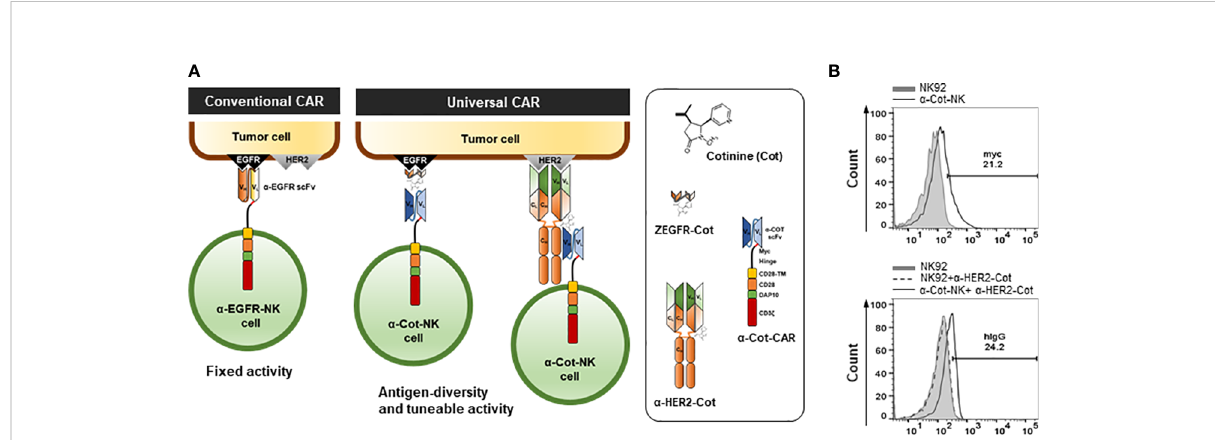
FIGURE 1 Engineering and establishment of a -Cot-NK92 cells as a universal CAR system (A) The conventional and universal CAR-NK system. (B) Levels of surface expression of CAR in NK92 or a -Cot-NK92 cells with/without a -HER2-Cot. The a -Cot-NK92 cells were cultured with puromycin for 3 d after a -Cot-CAR lentiviral transduction. Subsequently, transgene expression was evaluated using fl ow cytometry analysis (FACS) with a -Myc-PE (upper) and a -human IgG-PE conjugated antibody (hIgG, lower) after incubation with/without a -HER2-Cot. CAR, chimeric antigen receptor; Cot, cotinine; NK, natural